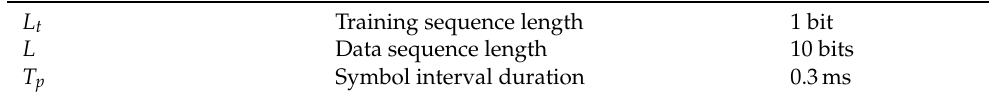
Figure 7. Simulation configuration for performance evaluation. Table 2. BER simulation